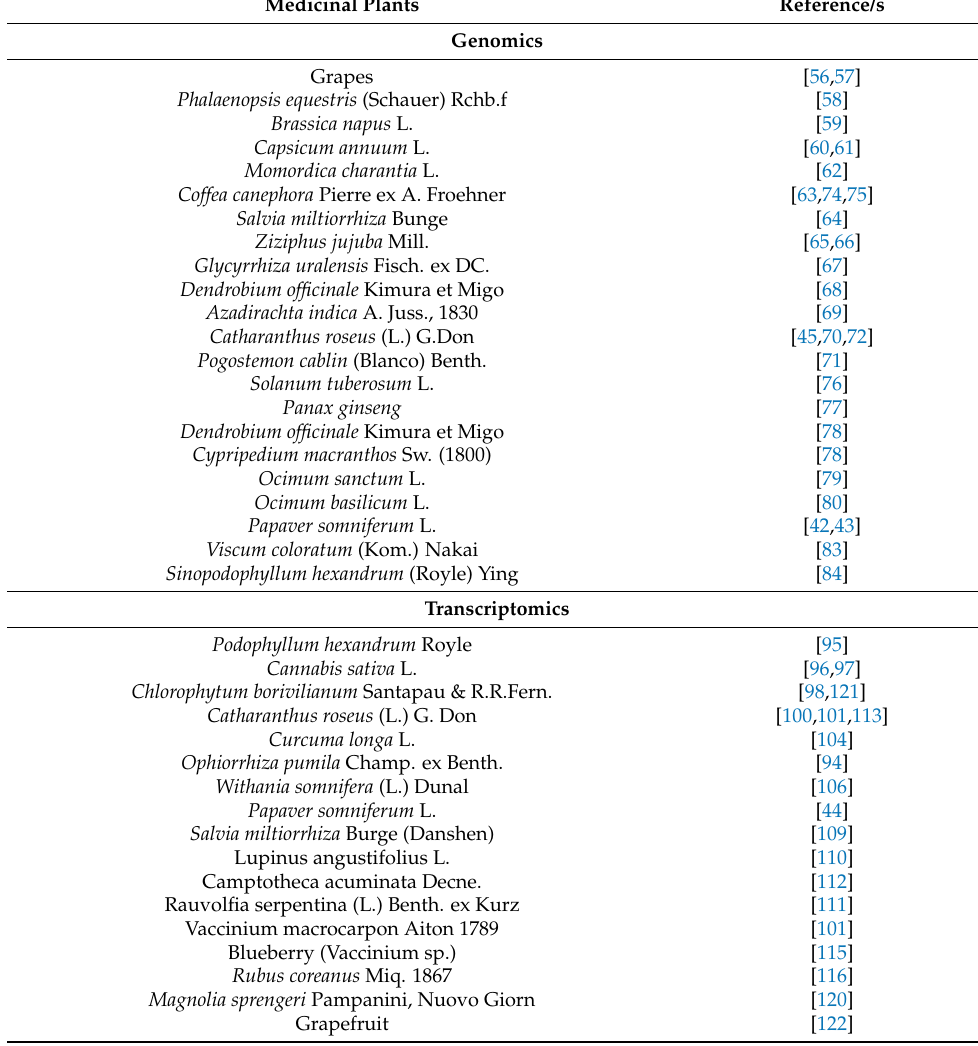
Table 1. Omics of Medicinal Plants Reported in